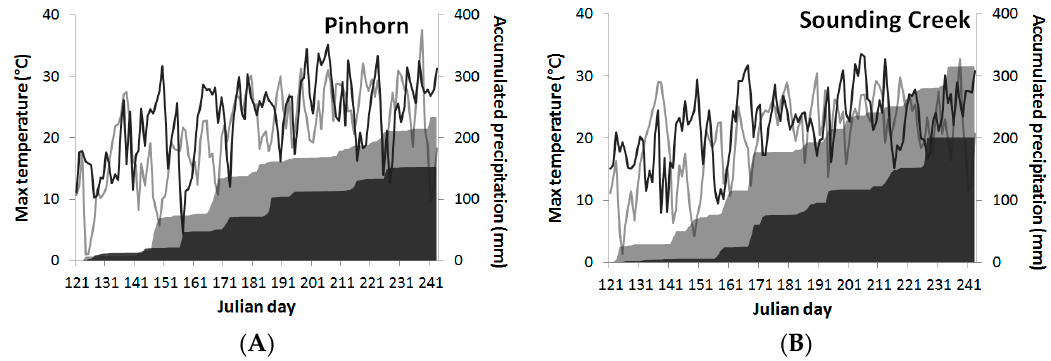
Figure 3. Maximum air temperature (lines) and accumulated precipitation (shadow) versus Julian day for the months of May, June, July and August in 2009 (black lines and shading) and 2010 (grey lines and shading) for the Pinhorn grazing reserve ( A ) and the Sounding Creek grazing reserve ( B ). The meteorological data are courtesy of Alberta Agriculture and Forestry.